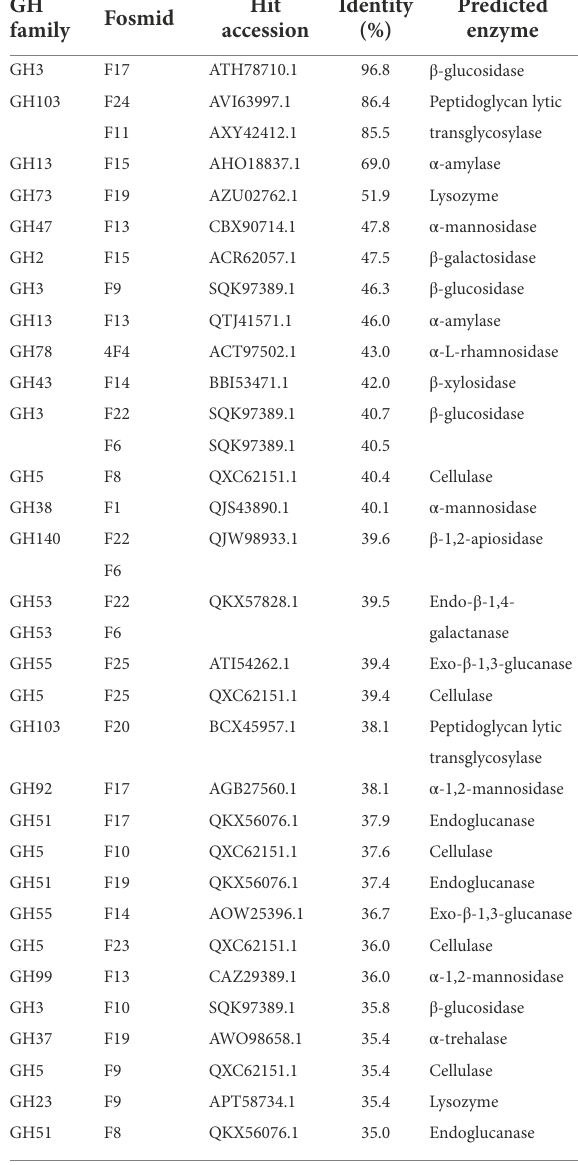
TABLE 4 Carbohydrate degrading enzymes detected in the fosmid clones (the complete list in Supplementary